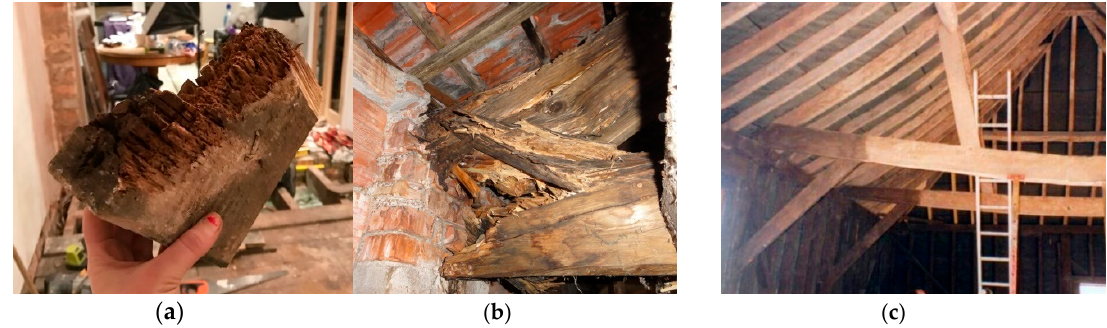
Figure 5. Different types of roof timber historic structures: ( a ) timber frame for a shed (skillion) roof; Figure 6. Examples of damage in timber structures: ( a ) and ( b ) Rotting wood at the beam-ends, and ( b ) traditional timber frame for a gable roof. at the joists in timber roof truss; ( c ) Deformed timber tie in a frame of a roof structure because of over-loading.